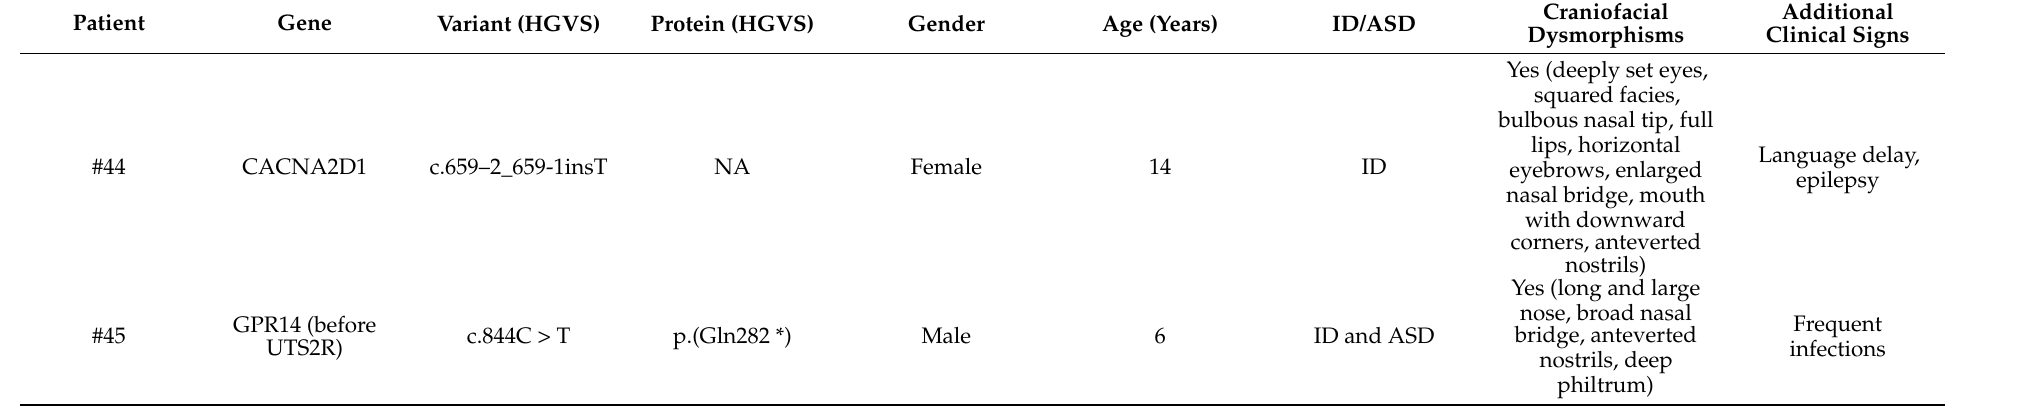
Table 2. Clinical features of patients with pathogenic variants in the new candidate